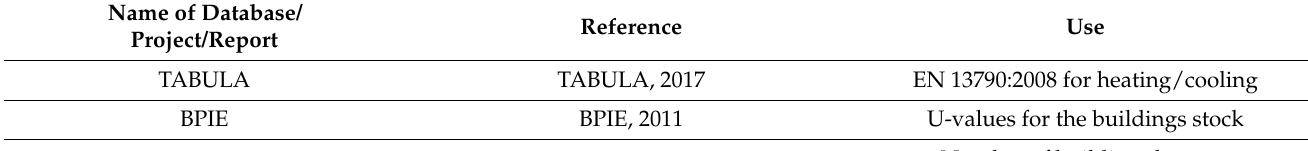
Table A1. List of databases, projects, and reports we combined and elaborated to build the database for the PRIMES-BuiMo building stock and energy consumption for the years 2005 to